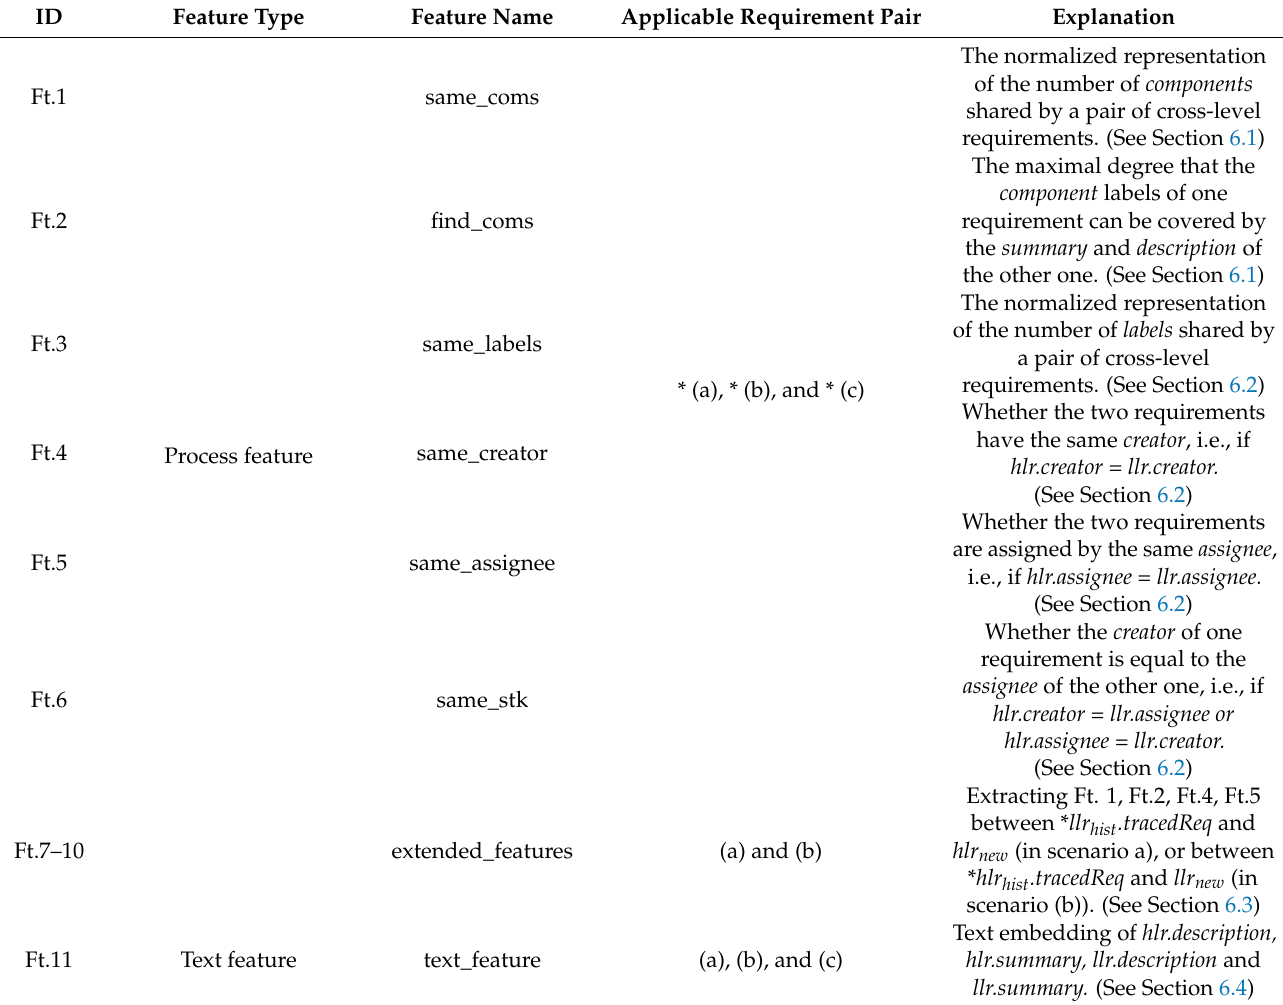
Table 1. Metadata-based feature extraction in